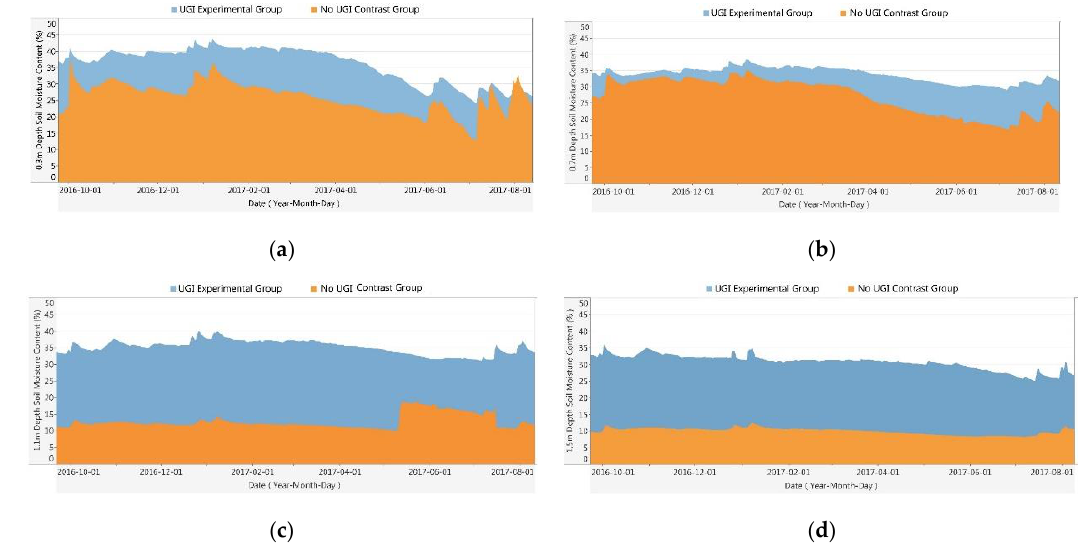
Figure 7. Comparison of soil moisture at depths of 0.3 m ( a ), 0.7 m ( b ), 1.1 m ( c ), and 1.5 m ( d ) between the UGI experimental group (blue) and the no UGI contrast group (orange) from October 2016 to August 2017.